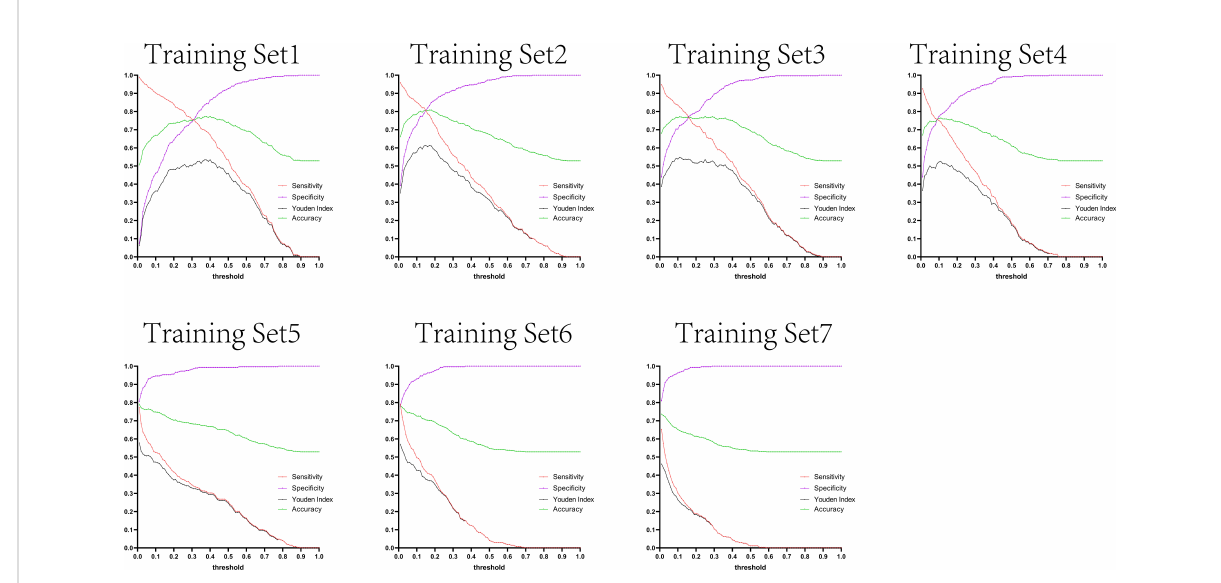
FIGURE 9 The trend lines graph of AUC value with the gradient of sample proportion in the training set models.